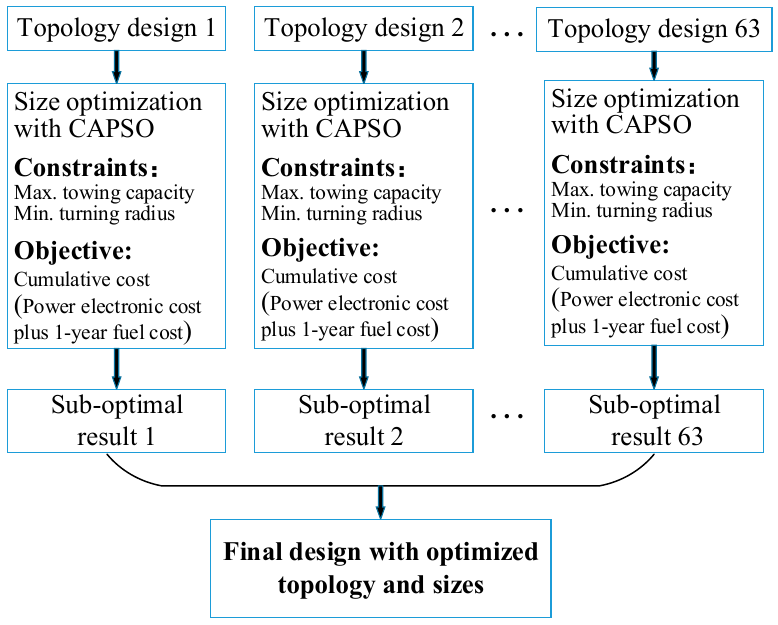
Figure 14. Integrated optimization procedure.